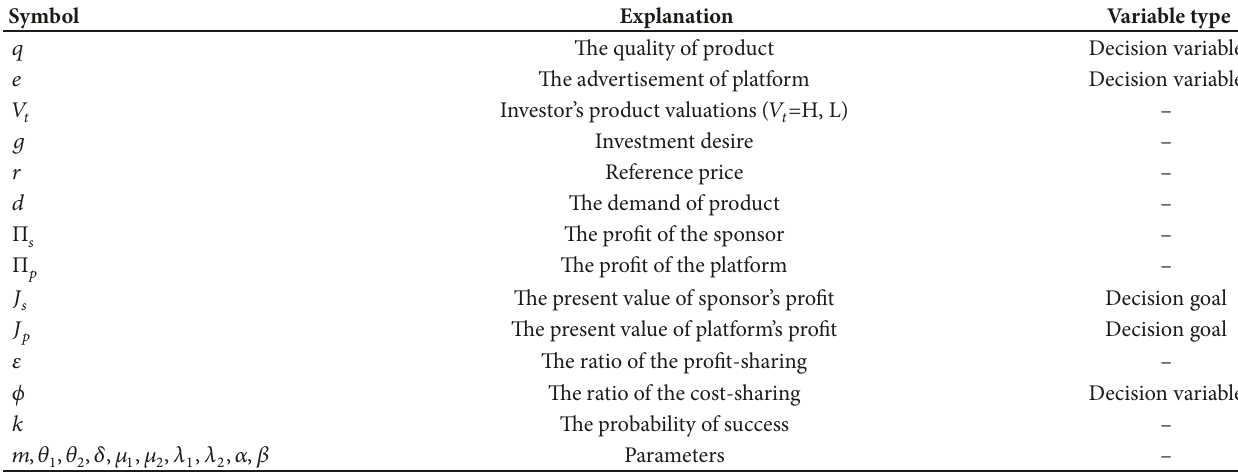
Table 1: Parameters